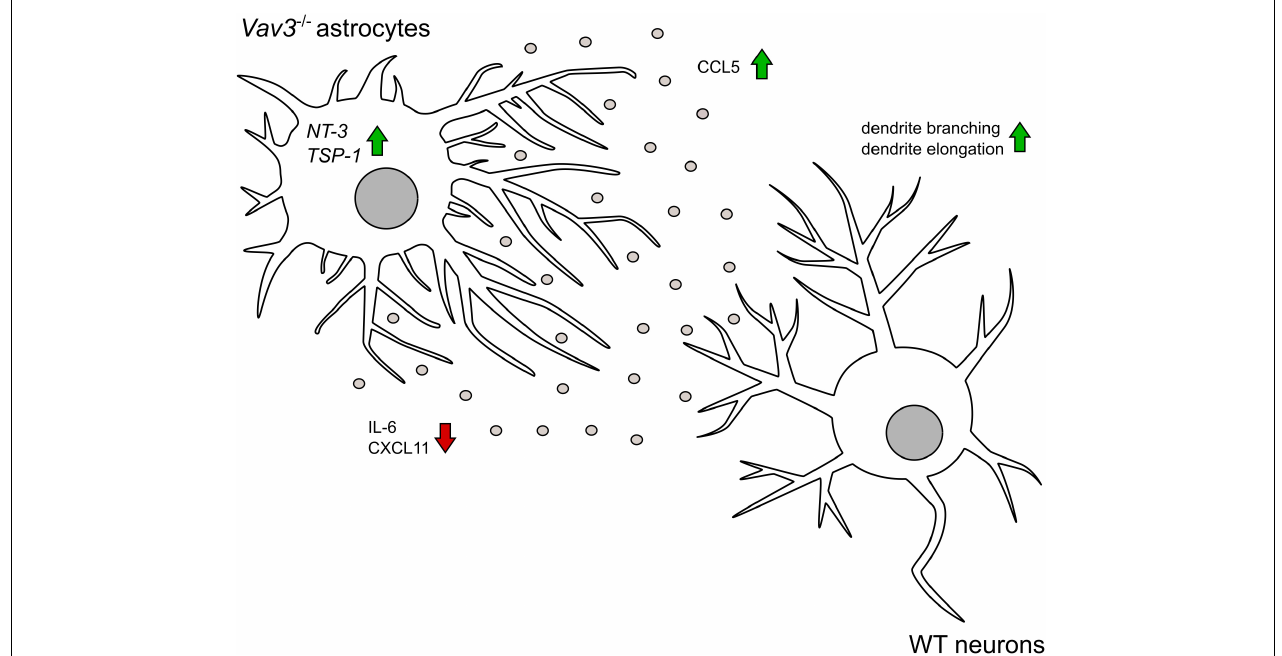
FIGURE 7 | The graphical abstract depicts that Vav3 − / − astrocytes promote the branching and the elongation of dendrites on wildtype neurons in an indirect co-culture system. Knockout astrocytes show a higher secretion of the chemokine CCL5 which has a neurotropic potential. Contrary, the pro-inflammatory cytokine IL-6 is released in lower amounts. In contrast to wildtype astrocytes, Vav3 − / − astrocytes do not release CXCL11. On mRNA level Vav3 − / − astrocytes express more NT-3 and TSP-1